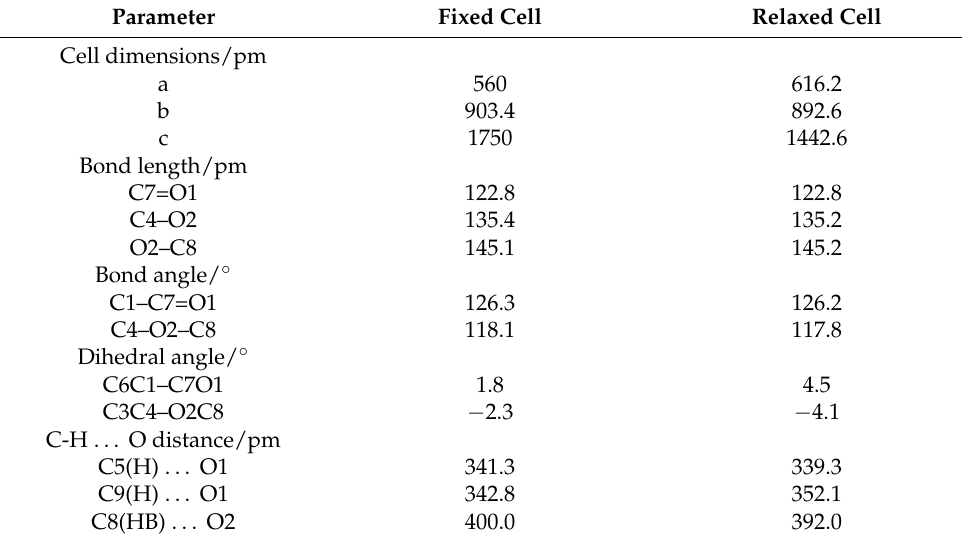
Table 5. Selected geometrical parameters for 4EtOB.